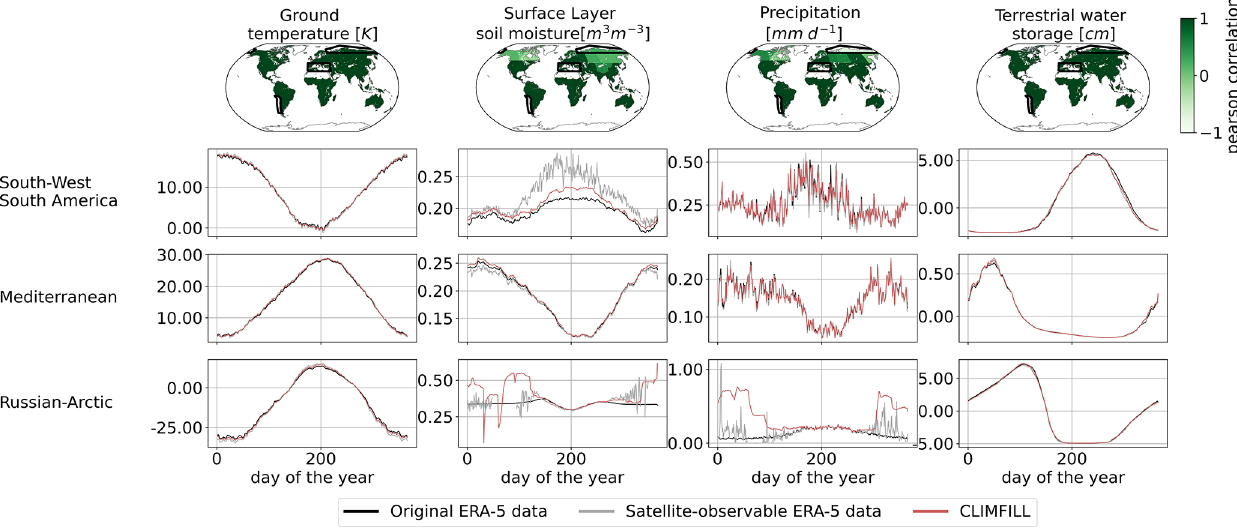
Figure 11. Pearson correlation of regionally averaged mean seasonal cycles between CLIMFILL and the original ERA-5 data over IPCC reference regions (AR6 regions, Iturbide et al., 2020) (top row). Regionally averaged mean seasonal cycle of the physical values over selected regions in original ERA-5 data, satellite-observed ERA-5 data, and gap-filled CLIMFILL data (bottom three rows). The selected regions show the advantages and problems of each framework. For more information, see Sect. 4.3. For all other AR6 regions, see Fig. A2 in Appendix A.